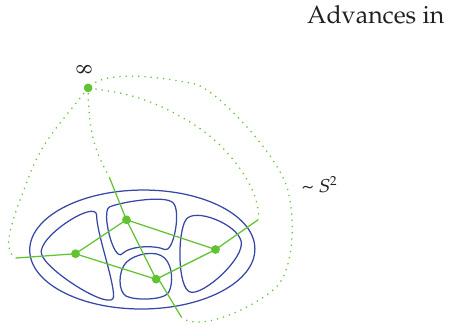
Figure 6: Dual surface constructed from the vacuum diagram in Figure 3 (cid:2) c (cid:3) . Note that points at infinity are identified.